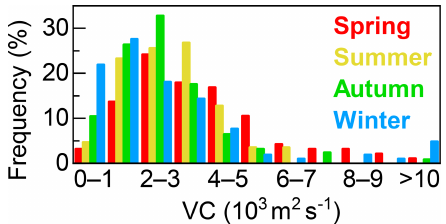
Figure 1. Monthly variations in mixing layer height (MLH), the wind speed in the mixing layer (WS ML ), the ventilation coefficient (VC) and PM 2 . 5 in Beijing.